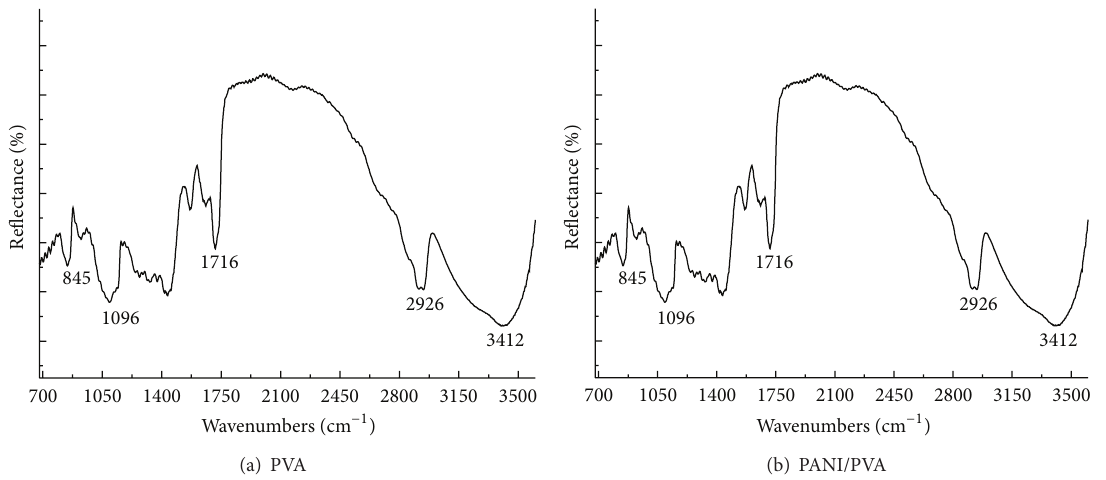
Figure 4: The FTIR absorption spectrum of PVA (a) and PANI/PVA (b).